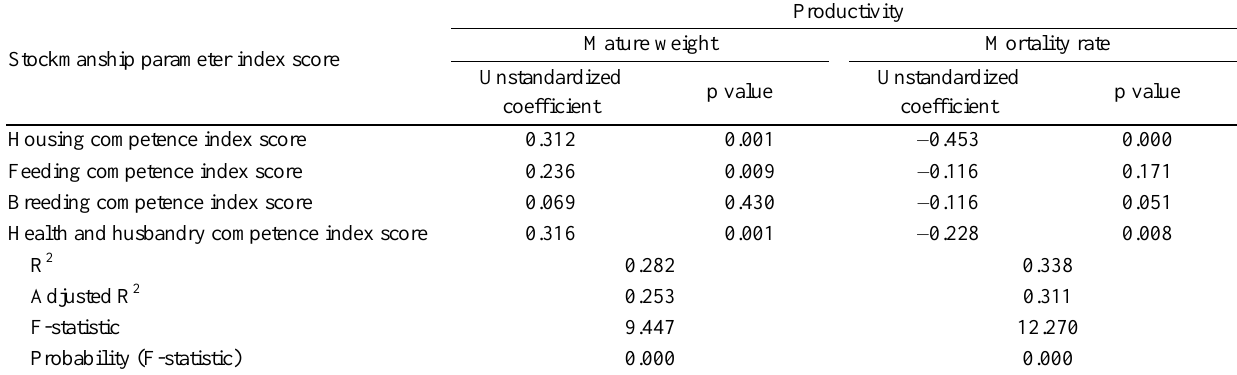
Table 4. Factors influencing goat productivity in terms of mature weight and mortality rate